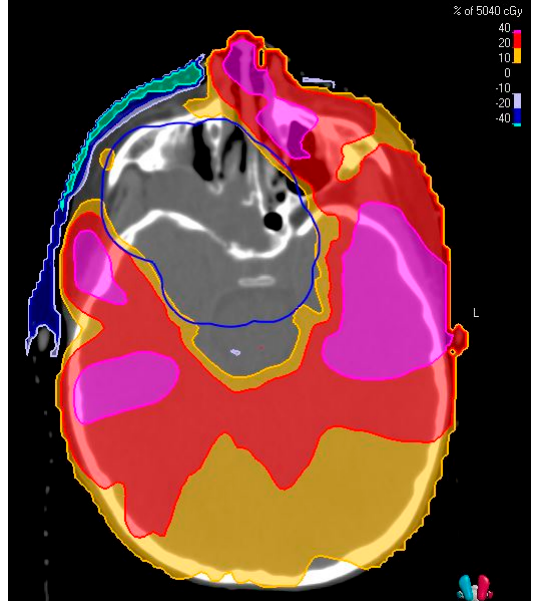
Figure 4. Difference in relative dose of a treatment plan as percentage of 5040 cGy when using volumetric arc-based therapy (VMAT) compared to proton therapy. Positive numbers on the scale indicate increased dose with VMAT.